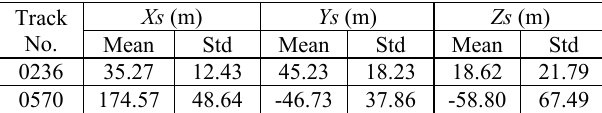
Table 5.Change of position elements of exterior orientation